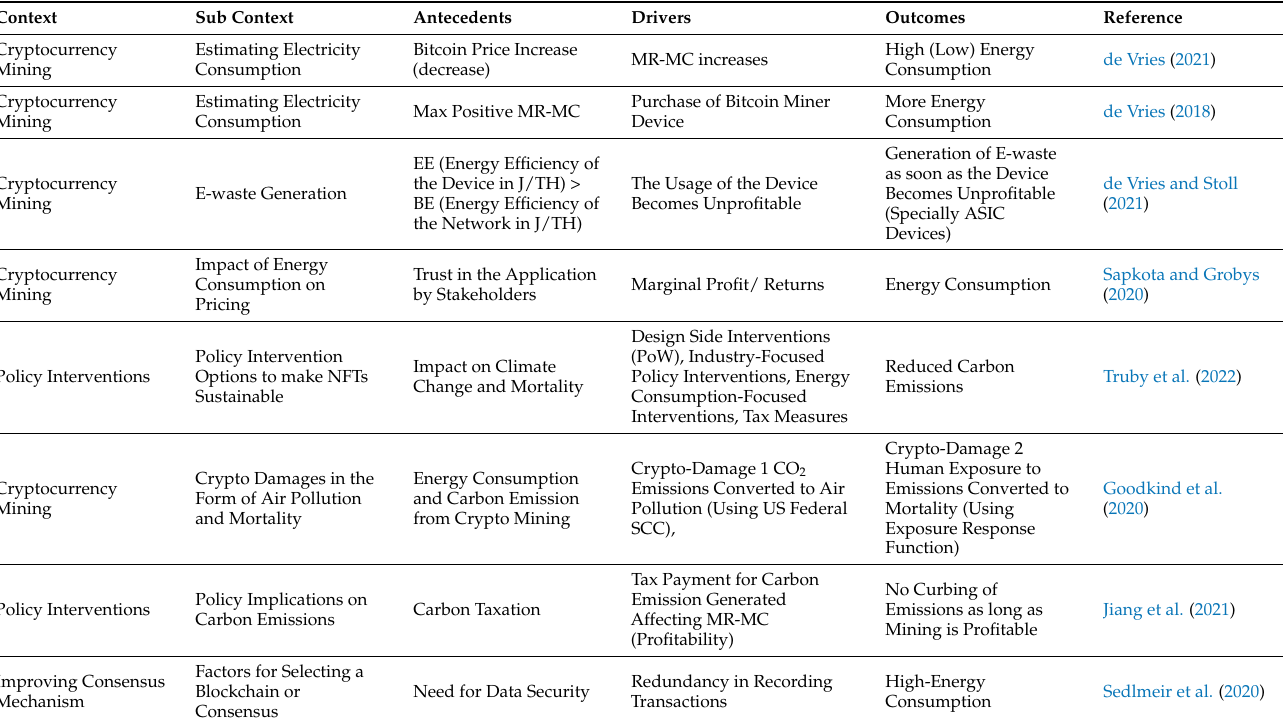
Table 10. Conceptualization of ADO